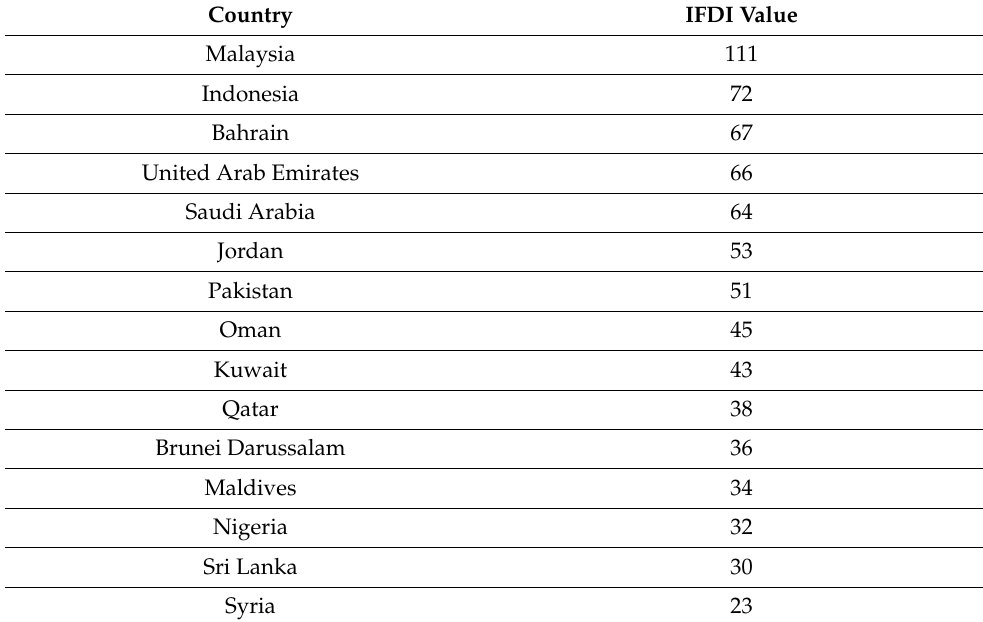
Table A1. The most developed Islamic finance